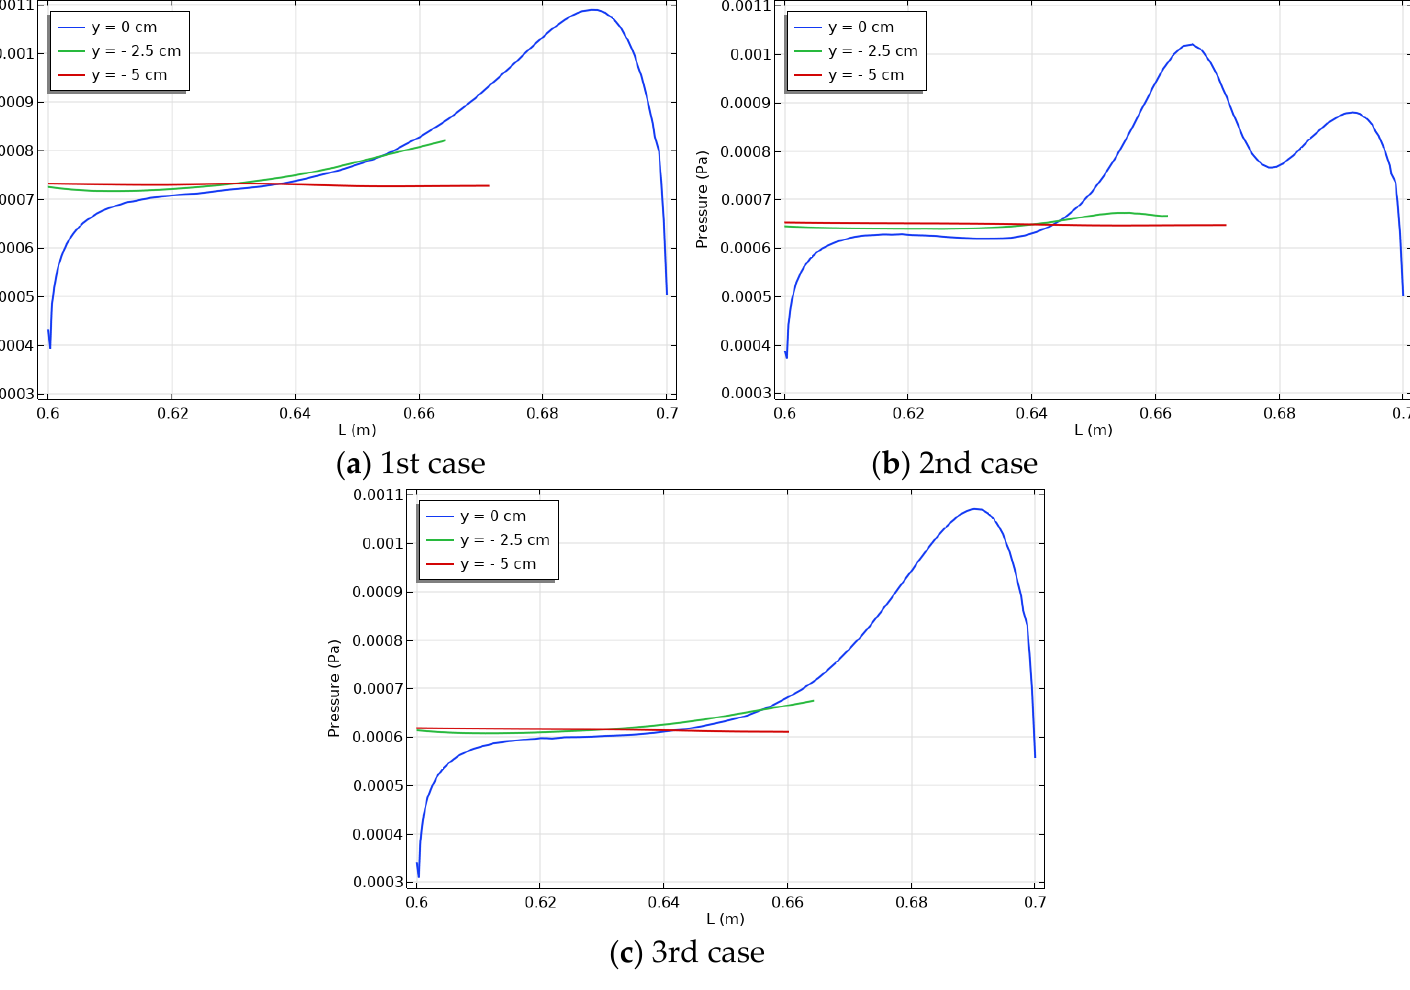
Figure 11. Pressure profile during the negative y axis in the cavity .